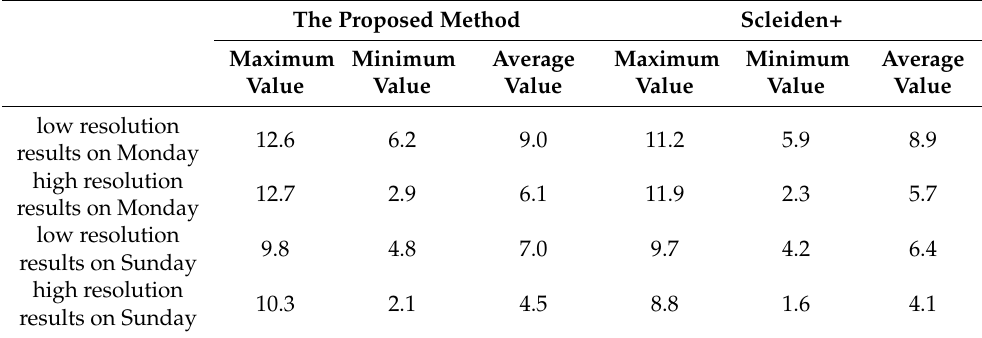
Figure 11. Low-resolution spatial communities discovered by the two methods during afternoon rush hours: ( a ) spatial communities identified by the proposed method on Monday; ( b ) spatial communities identified by Scleiden+ on Monday; ( c ) spatial communities identified by the proposed method on Sunday; and ( d ) spatial communities identified by Scleiden+ on Sunday. Table 4. AF index values of the spatial communities identified by the proposed method and Scleiden+ during afternoon rush